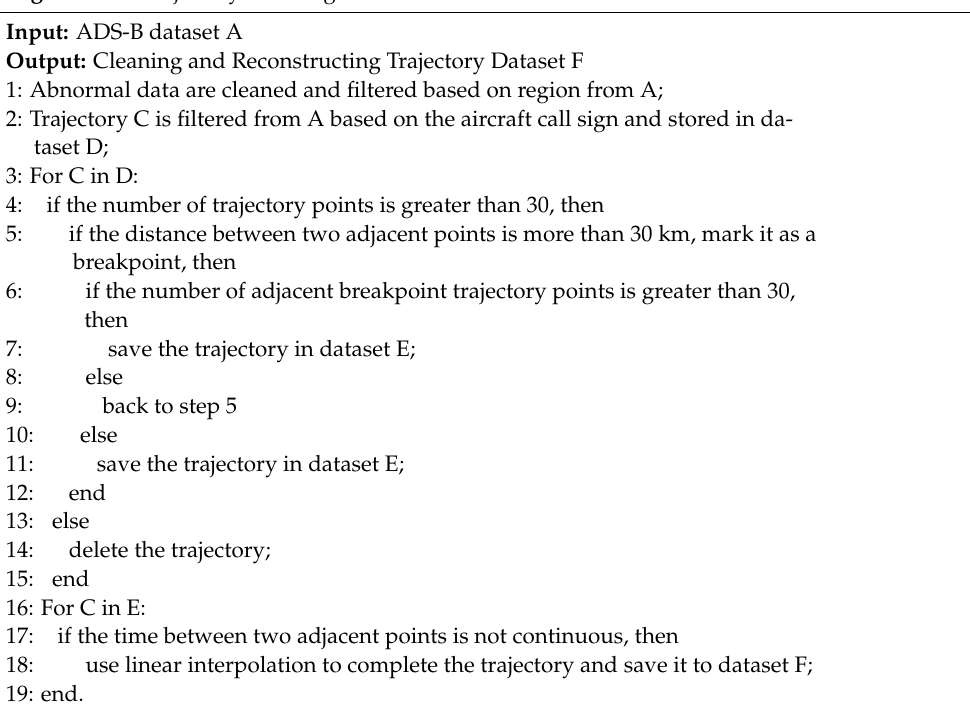
Algorithm 1: Trajectory Cleaning and